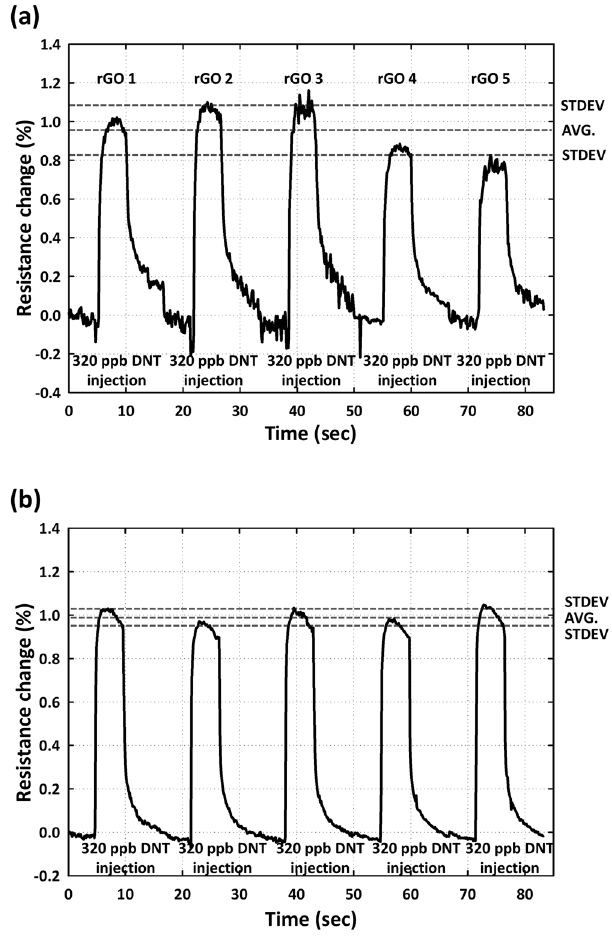
Figure 6. Reproducibility and sensor regeneration test for ( a ) multiple devices and ( b ) multiple runs. The resistance change measured during multiple runs is reproducible (shown here for 320 ppb DNT), and the trace in ( b ) also confirms complete regeneration of the sensor surface between successive runs at room temperature by using